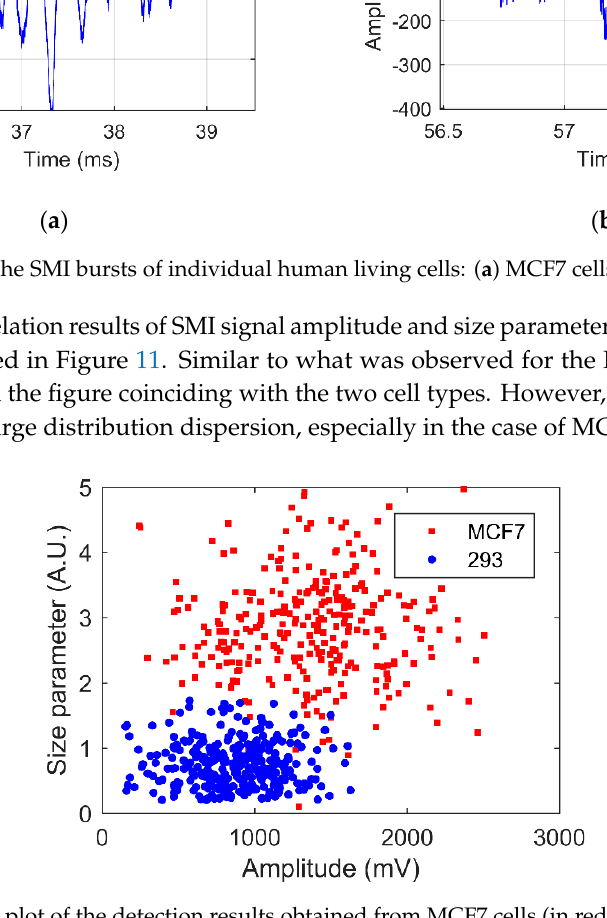
Figure 11. Scatter plot of the detection results obtained from MCF7 cells (in red); 293 cells (in blue).